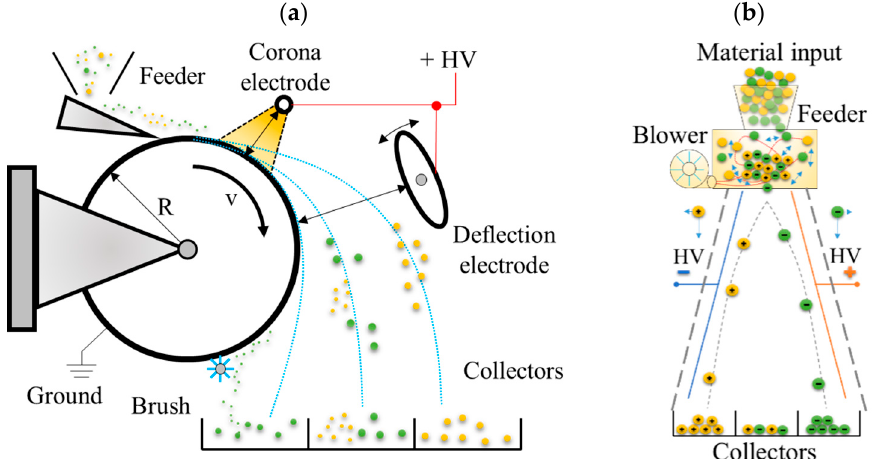
Figure 1. Illustration of electrostatic separation process in the example of a drum type separator ( a ) and free-fall type ( b ).